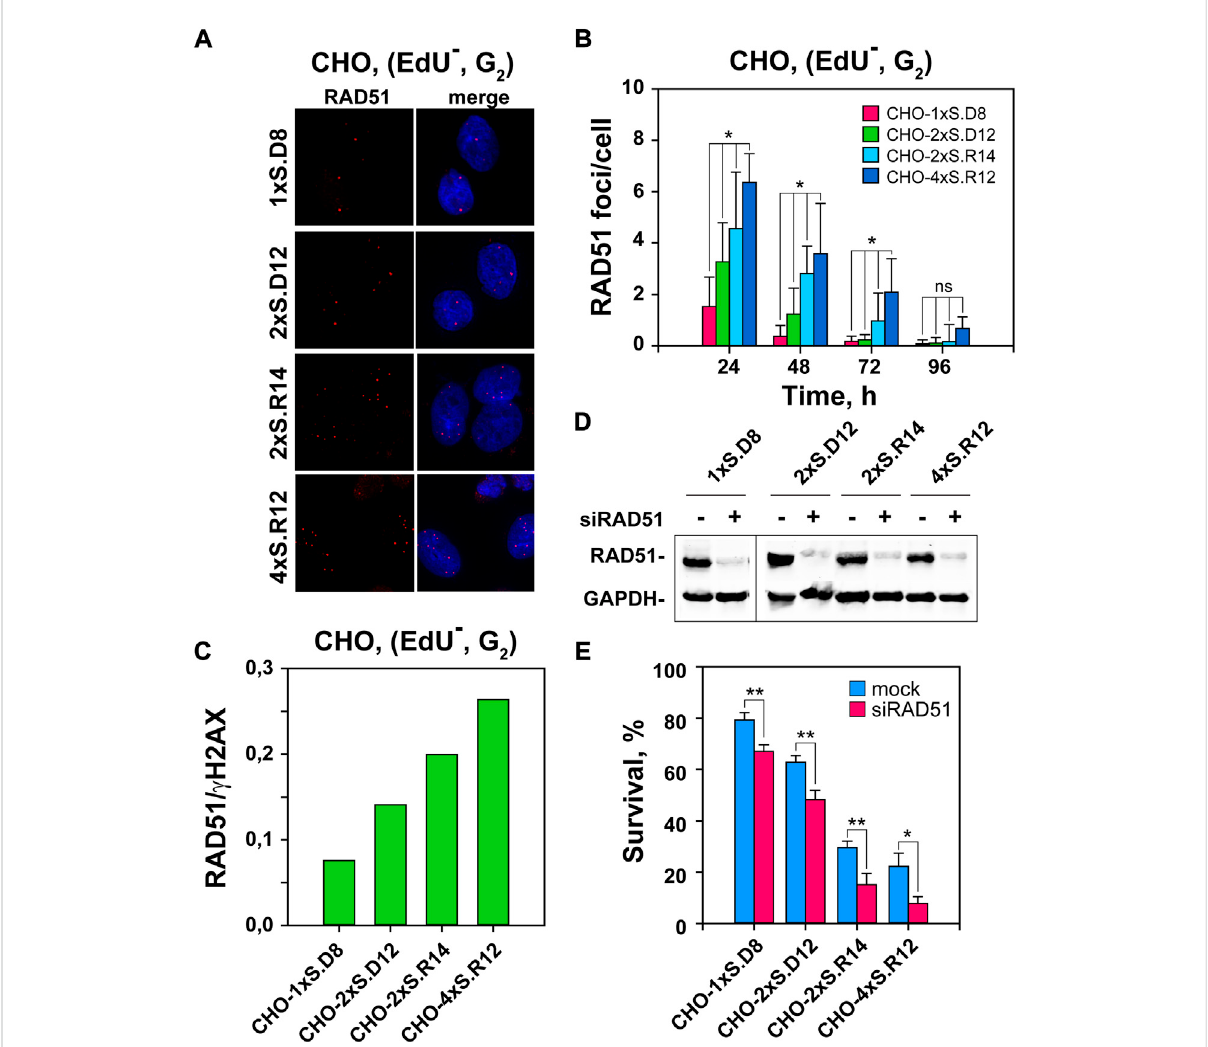
FIGURE 3 StrongerRAD51accumulationtoDSB-clustersthanindividualDSBs. (A) RepresentativeimagesofRAD51fociinI-SceI-transfectedCHOclones. (B) QIBC of RAD51 foci, speci fi cally in the EdU – G 2 -phase cells. The selection of EdU – , G 2 -phase cells is according to the gates de fi ned in Supplementary Figure S1B. Only results for EdU – , G 2 -phase cells are presented, as there are no detectable RAD51 foci in the G 1 -cell population. (C) Ratio between RAD51 and γ H2AX foci in the indicated CHO clones, as a measure of the fraction of DSBs that engage HR. It is calculated using the data from the 24 h time point, where the maximum in RAD51 foci is observed and γ H2AX foci numbers are close to the maximum measured at 12 h (D) Western-blot analysis showing the level of RAD51 depletion. (E) Survival of transfected cells after depletion of RAD51 recombinase by siRNA interference calculated using the plating ef fi ciency measured in mock-transfected cells of the corresponding clone. Data represent means and standard deviations (±SD) from three independent experiments. (ns, no signi fi cance, p > 0.05); (* p ≤ 0.05); (** p ≤ 0.01); (*** p ≤ 0.001); (**** p ≤